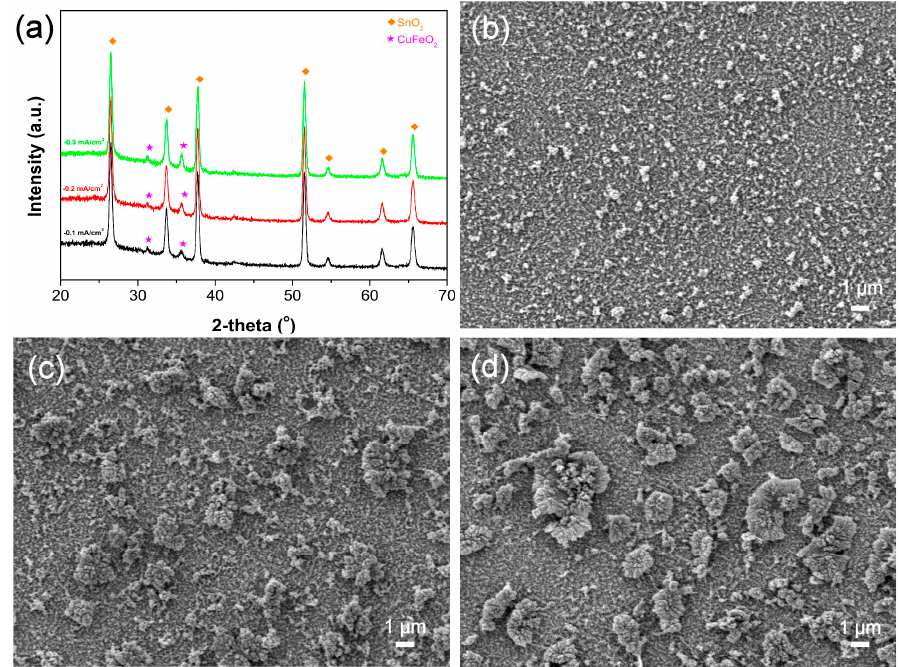
Figure 4. ( a ) XRD patterns of electrodeposited CuFeO 2 film by applying different current densities: − 0.1 mA cm − 2 (black), − 0.2 mA cm − 2 (red), and − 0.3 mA cm − 2 (green). Top view SEM images of electrodeposited CuFeO 2 film by applying different current densities of ( b ) − 0.1 mA cm − 2 , ( c ) − 0.2 mA cm − 2 , and ( d ) − 0.3 mA cm − 2 . Electrodeposition was carried out in DMSO based electrolytes containing 1 mM Cu(NO 3 ) 2 · xH 2 O/3 mM Fe(ClO 4 ) 3 · xH 2 O/100 mM potassium perchlorate for 30 min. Electrodeposited films were annealed at 650 ◦ C for 1 h under N 2 gas flow.